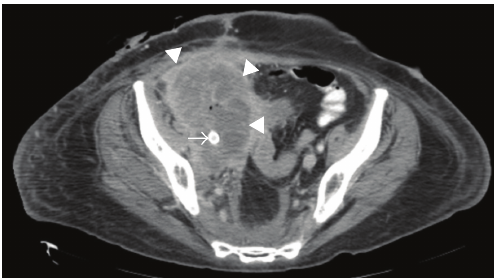
Figure 7: Contrast-enhanced CT scan, obtained four months after-stent insertion, demonstrates interval local tumor progres- sion (arrowheads) but maintained patency of stented iliac artery